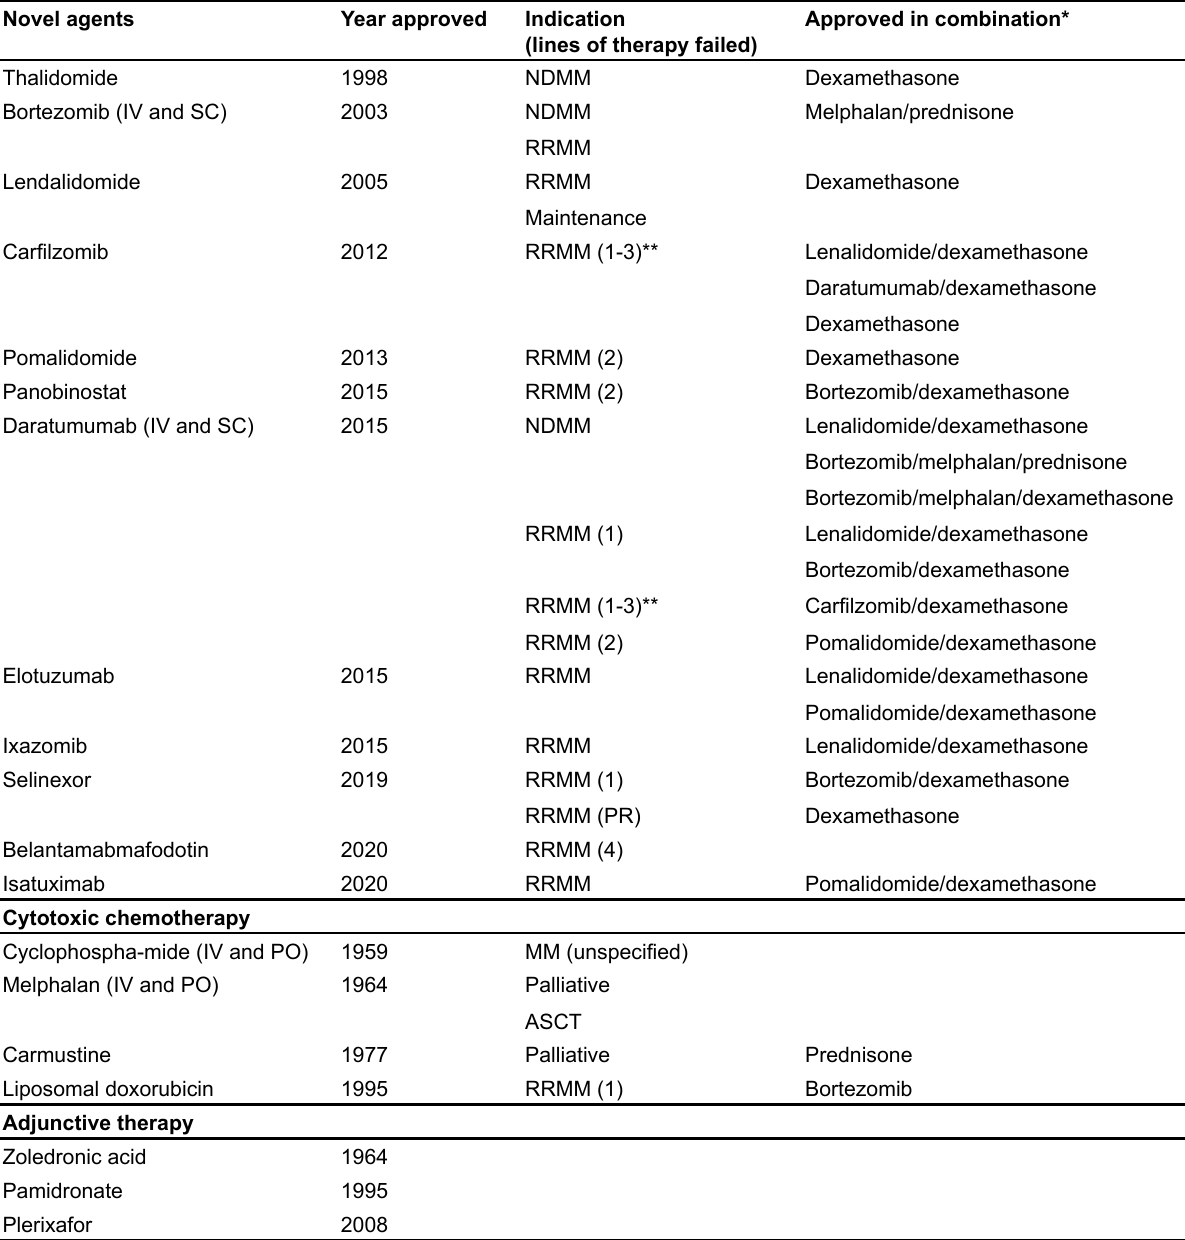
Table 1. List of drugs used in MM with FDA approval and labeled indications Novel agents Year approved Indication (lines of therapy